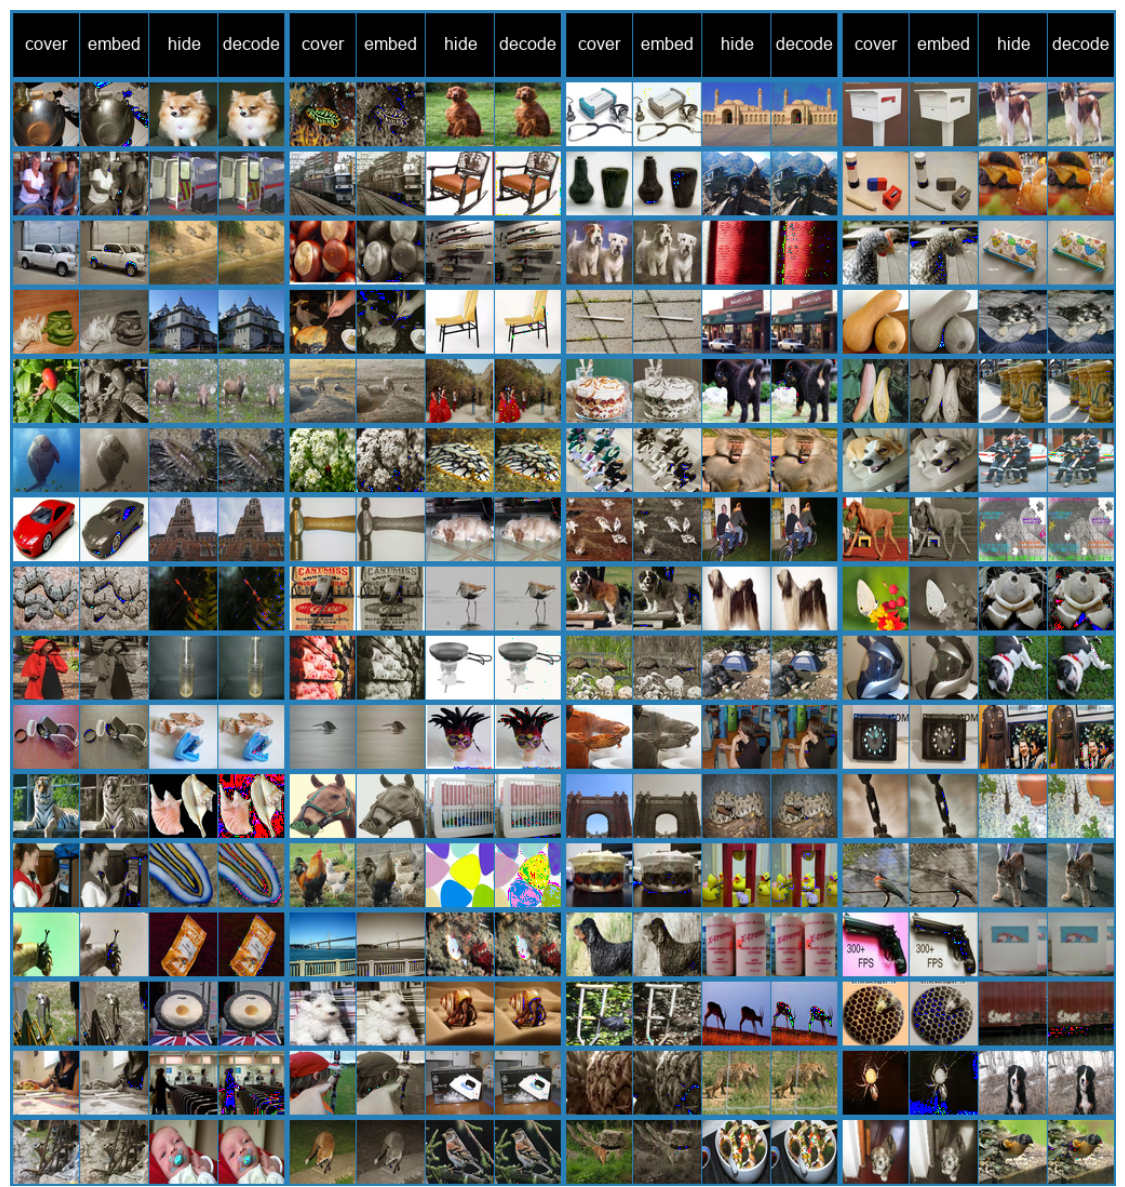
Figure 13. One batch Steganography